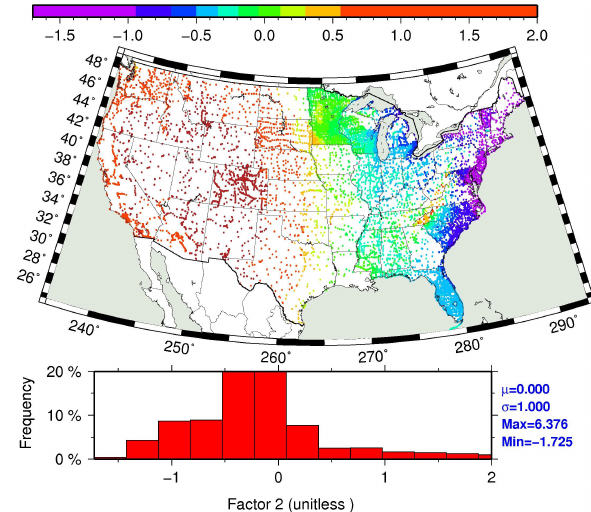
Figure 8: The second factor scores of the FA